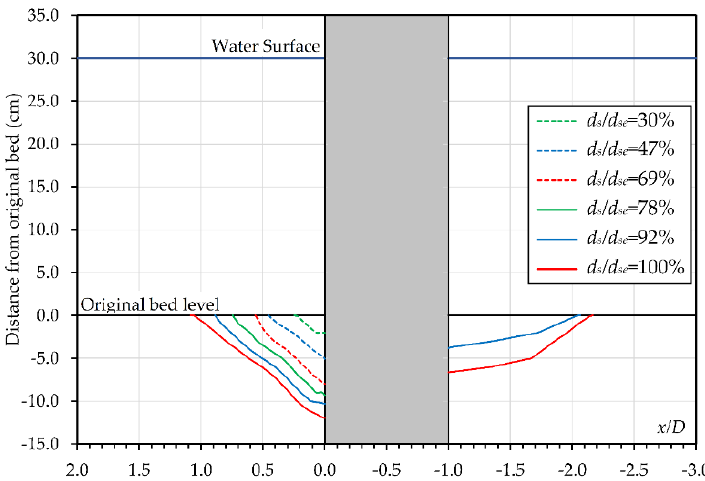
Figure 2. Variation of the scour hole bed level at the plane of symmetry during the scour